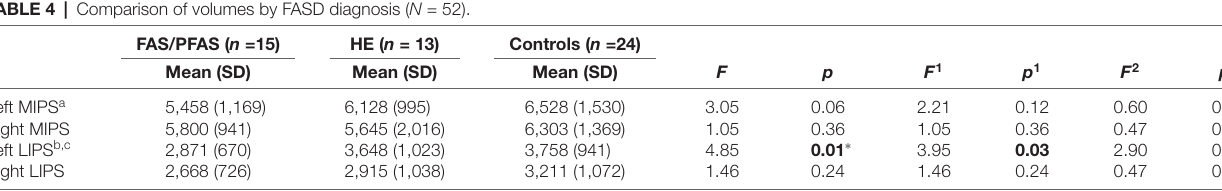
TABLE 4 | Comparison of volumes by FASD diagnosis ( N =